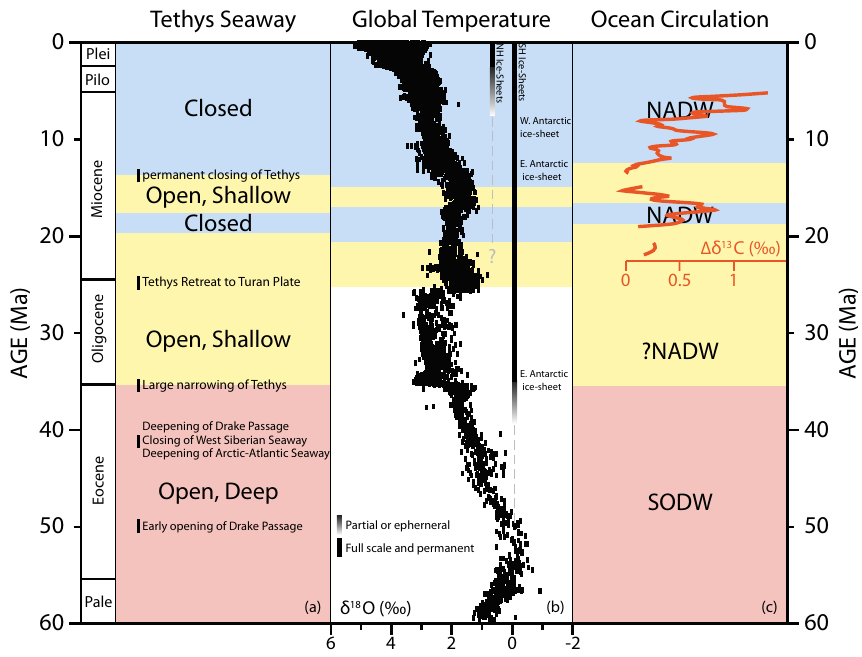
Figure 7: Timing of key geological events, 1) the evolution of the Tethys Seaway, 2) Cenozic cooling based on deep-sea oxygen isotopes and ice-sheet development (Zachos et al., 2001, 2008), 3) the evolution of ocean circulation. The Tethys evolution is summarized according to Akhmet’ev and Beniamovski (2006), Rögl (1996), Barrier and Vrielynck (2008). The changes of other seaways are summarized according to Scotese (2001), Livermore et al. (2005) and Scher and Martin (2006). The Early Oligocene evidence of NADW formation is summarized according to Davies et al. (2001), Via and Thomas (2006) and Scher and Martin (2008). The red line show the NADW index based on benthic carbon isotopes (Wright et al., 1992). The high value of Δδ 13 C indicates active NADW, and the low value indicates inactive NADW.